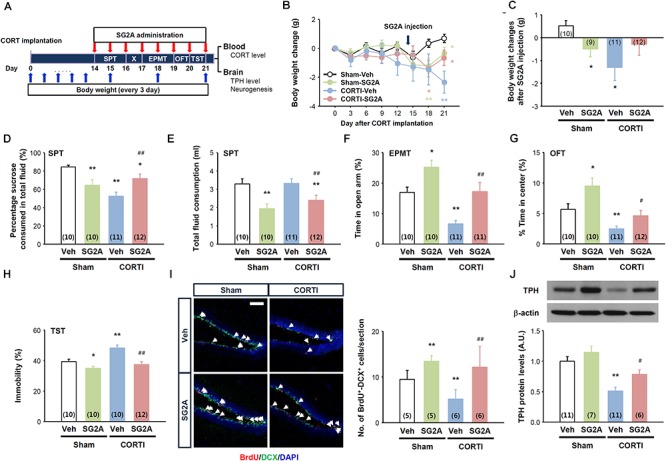
Effects of SG2A on body weight change and anxiety/depression-like behaviors in mice with corticosterone pellet implantation (CORTI) and in sham-operated mice. (A) Experimental scheme for SG2A administrations and behavioral tests after CORTI. SG2A or vehicle (Veh) was administered to CORTI or sham-operated mice for 8 consecutive days, during which body weight measurement, the sucrose preference test (SPT), elevated plus maze test (EPMT), open field test (OFT), and tail suspension test (TST) were conducted. After all behavioral tests, blood and brain samples were collected for determination of CORT levels, neurogenesis in the dentate gyrus of the hippocampus, and tryptophan hydroxylase (TPH) protein levels in the dorsal raphe nucleus. (B,C) Body weight changes during 3 weeks of CORT implantation and after SG2A administration [arrow in panel (B)] for 7 days. Effects of SG2A on sucrose preference (D), total fluid consumption (E), times in the open-arm in the EPMT (F) and in the center in the OFT (G), and immobility of mice in the TST (H). (I) Immunohistochemistry of BrdU (red), doublecortin [(DCX) green] and DAPI (blue) (left) and mean number of BrdU+DCX+ cells (right) in the DG of the hippocampus (5–6 slices were counted per mouse). (J) Western blot for tryptophan hydroxylase [(TPH) top] and TPH levels in the DRN (bottom). Data are presented as means ± SEMs; ∗P < 0.05 and ∗∗P < 0.01 vs. Sham-Veh, #P < 0.05 and ##P < 0.01 vs. CORTI-Veh. Numbers in parentheses indicated the numbers of animals used for each group. Scale bar, 50 μm.